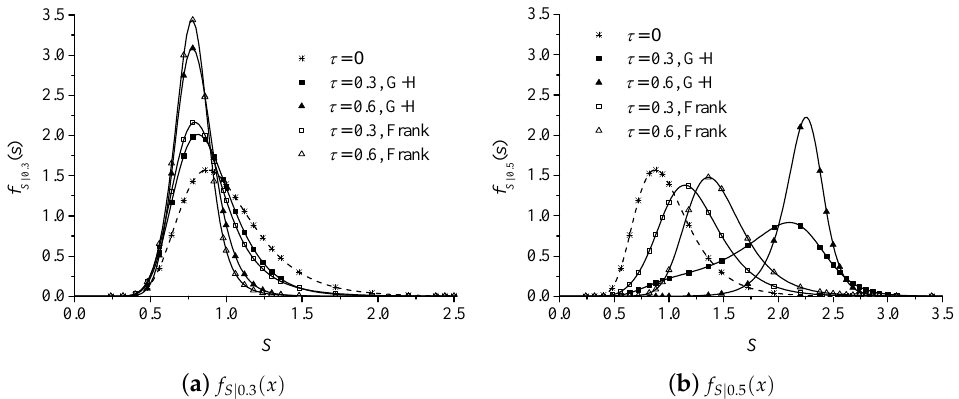
Figure 2. f S | 0.3 ( x ) and f S | 0.5 ( x ) for the cases of τ S , G ( T ) = 0, 0.3 and 0.6 respectively.